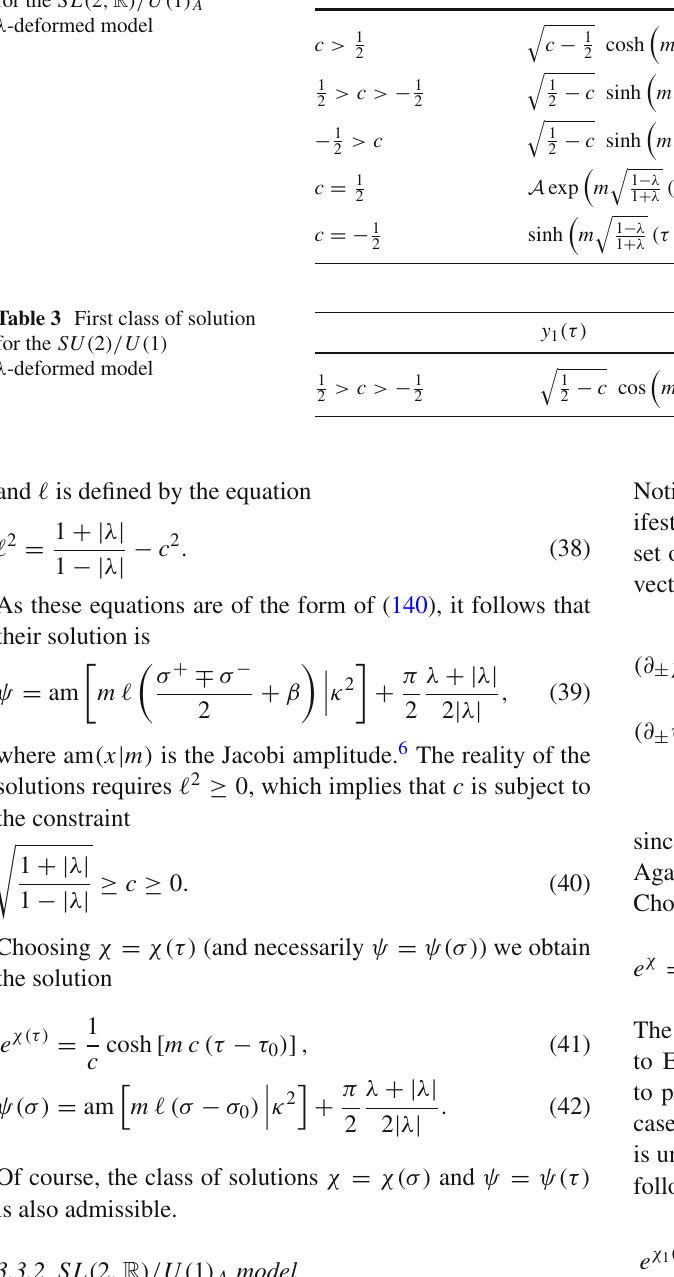
Table 2 First class of solution for the SL ( 2 , R )/ U ( 1 ) A λ -deformed model